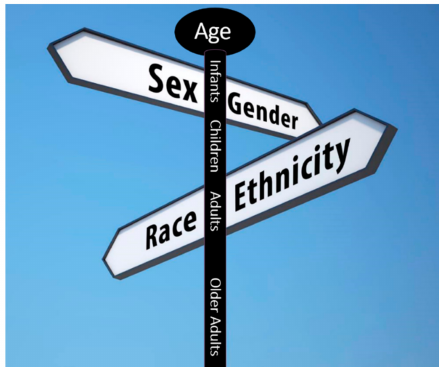
Figure 1. When considering the direction in which to take biomedical research, the influences of sex, gender, race, ethnicity, and the entire life course must all be taken into account in an integrated fashion. The graphic illustrates the intersectional relationships between these essential